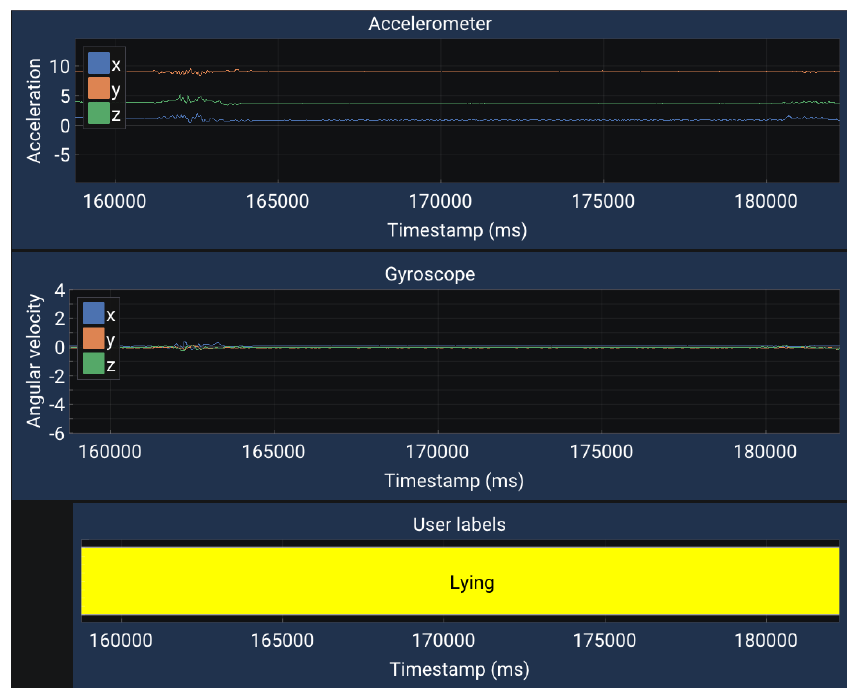
Figure A5. 20 s extracted from LYING session of subject